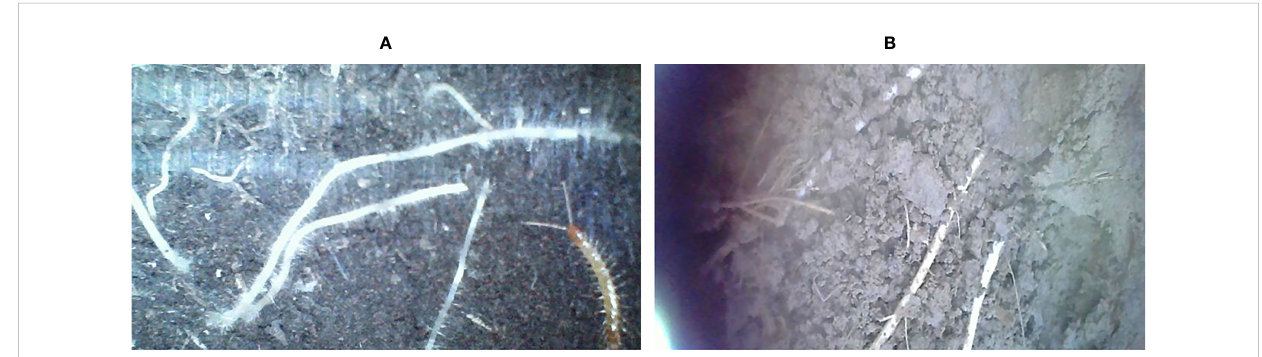
FIGURE 12 Partial data display. (A) Peanuts cultivated in black soil, (B) Corn cultured in tidal